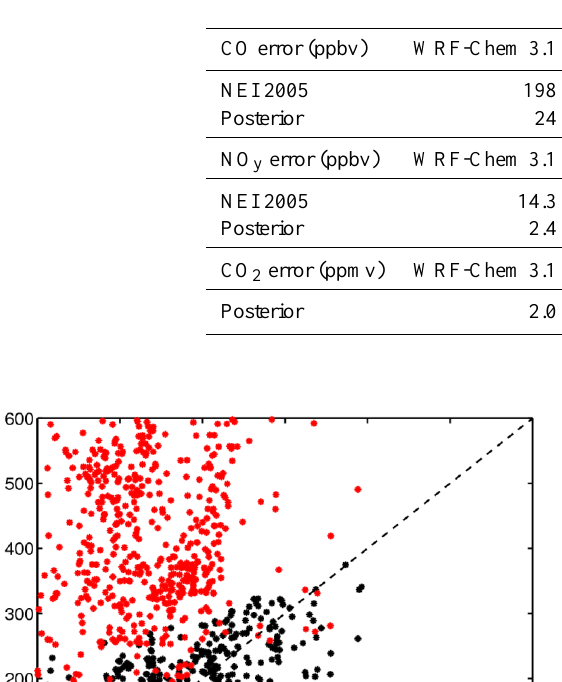
Table 2. Average errors in CO, NO y and CO 2 mixing ratios for the weekday CalNex P-3 flights using the 3 different WRF configurations or the ensemble and using NEI 2005 or posterior estimates. The average measured concentration above background was 86ppb for CO, 10.6ppb for NO y , and 9.6ppm for CO 2 .